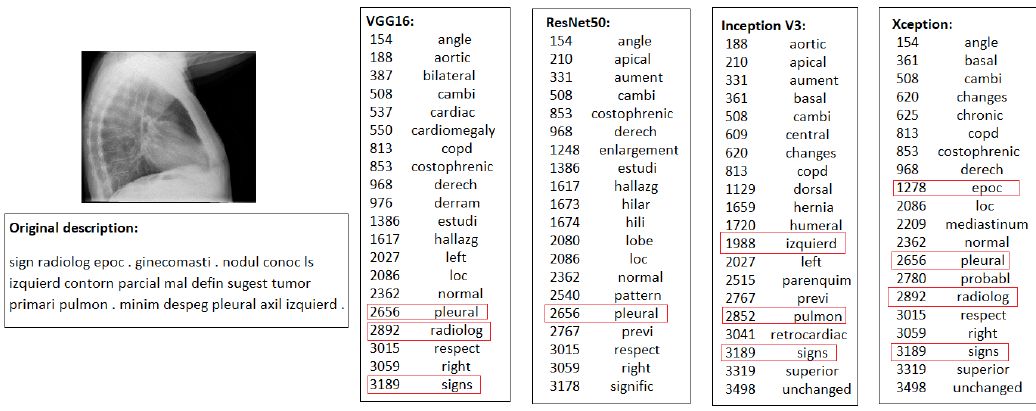
Figure 8. PadChest Data set: Comparison between original and generated description using different types of image features. Similar descriptors are marked in red rectangle.